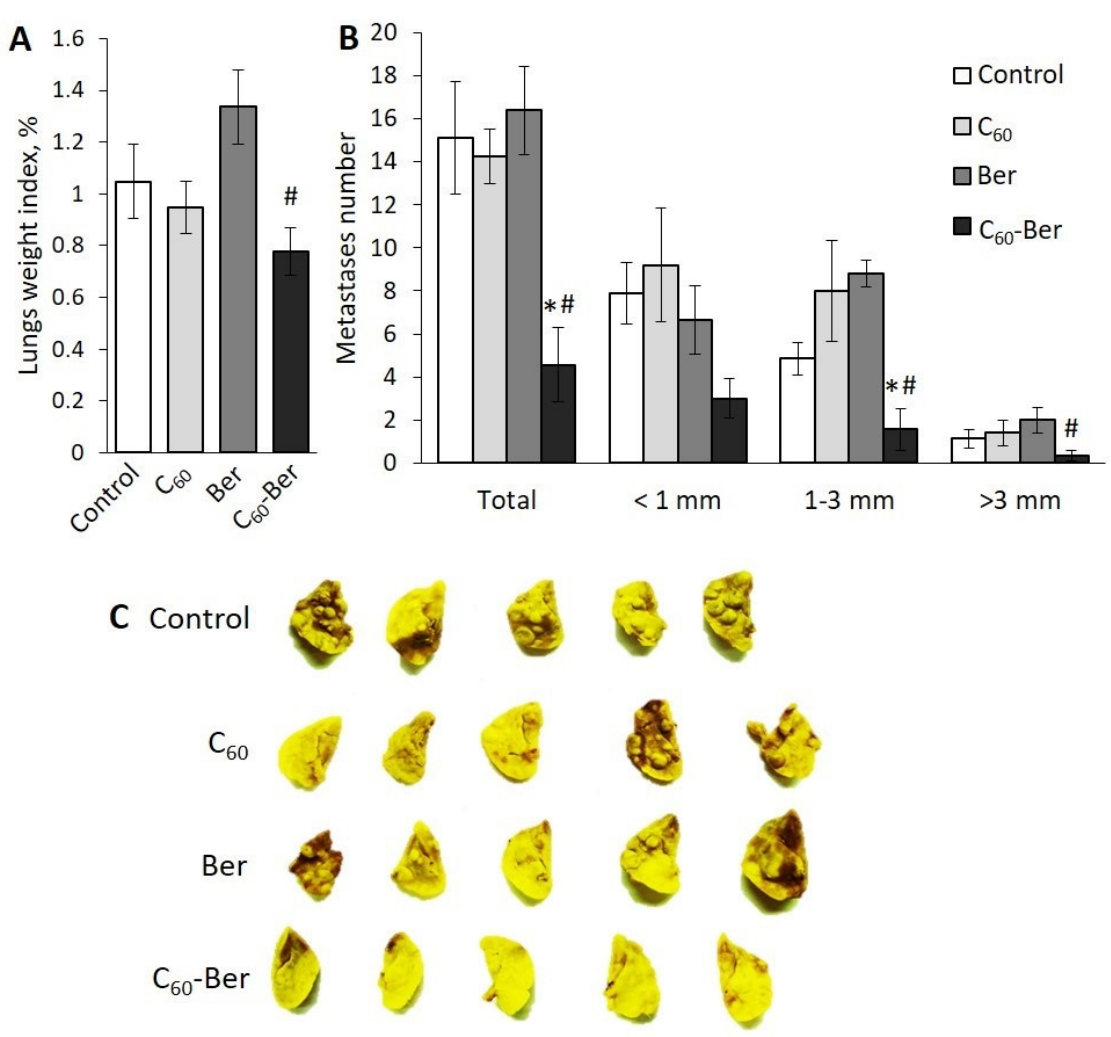
Figure 5. С 60 -Ber nanocomplex effectively suppresses metastasis of LLC cells in vivo: ( A )—lung weight index at day 29 after LLC cells inoculation; ( B )—the number of metastases of different size in lung tissue; ( C )—representative photographs of lungs. * p < 0.05 compared to control; # p < 0.05 compared to free Ber.